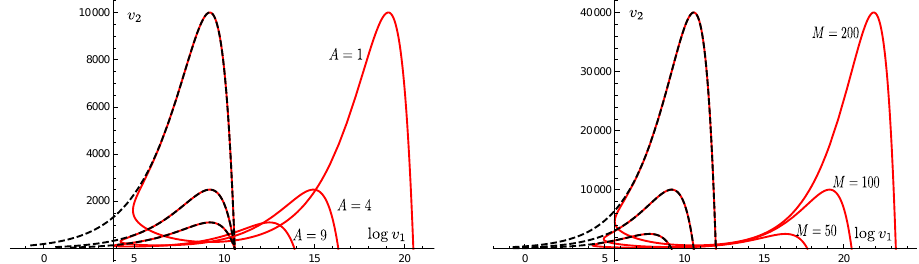
) in solid red, , v 1 2 = λ = 1, as well as L = 1 2 0